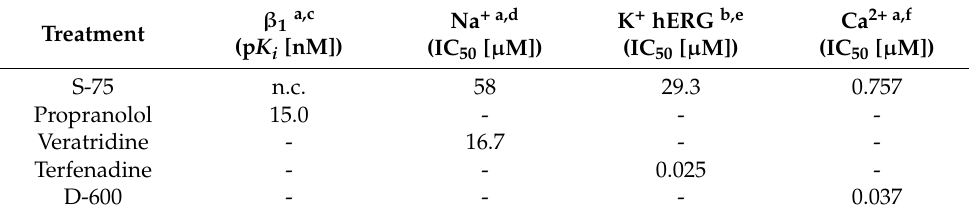
Table 1. The affinity of S-75 for adrenergic β 1 receptors, Na + , Ca 2+ and K + channels. Treatment